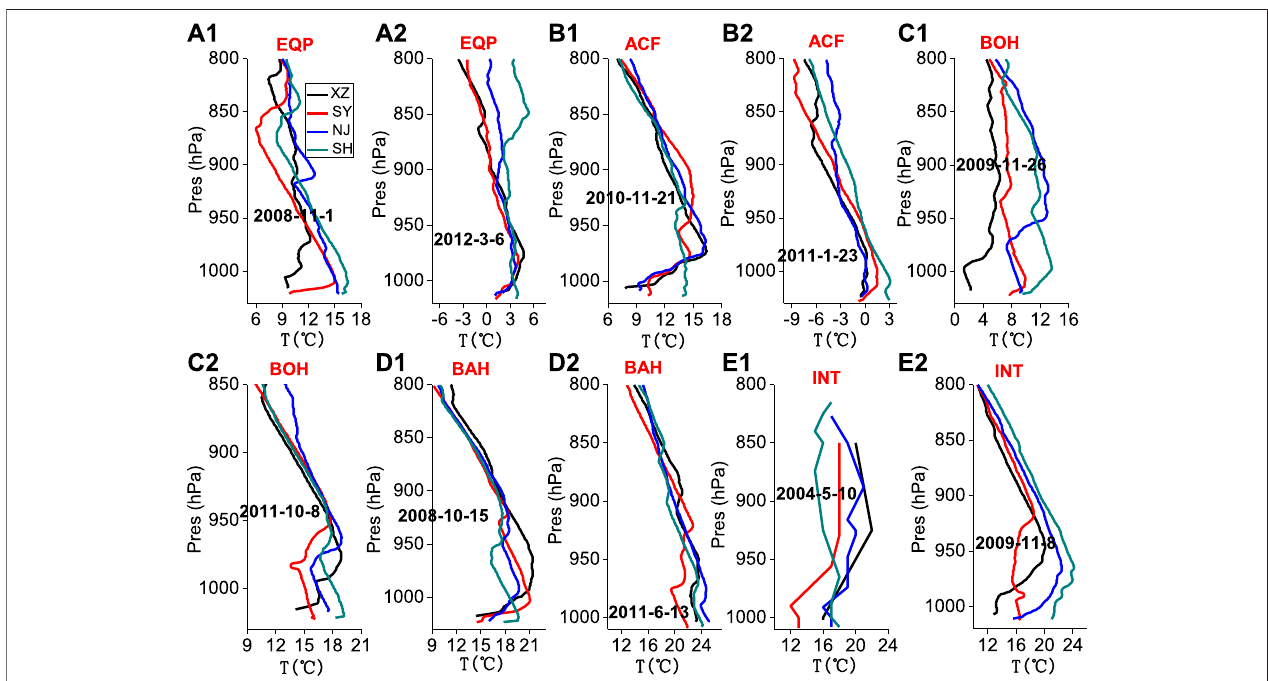
FIGURE 5 | Typical temperature pro fi les of regional heavy hazes at XZ, SY, NJ, and SH: (A) EQP, (B) ACF, (C) BOH, (D) BAH, and (E) INT. The x -axis is the temperature, and the y -axis is the pressure. After Peng et al. (2016).